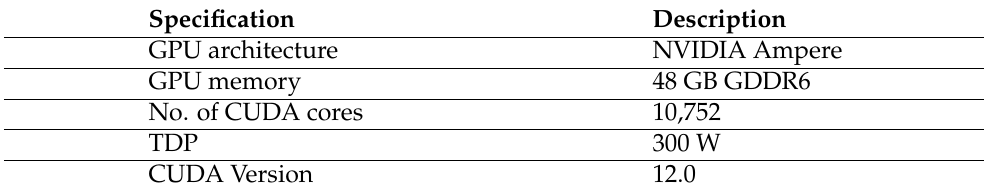
Table 1. Specifications of Nvidia A40